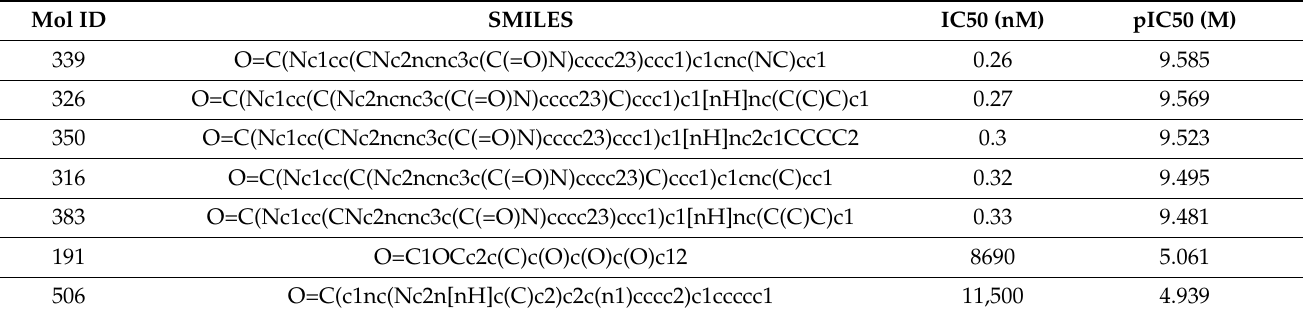
Table 4. SMILES notation, IC50 (nM), and pIC50 (M) of five most and least active molecules of the selected